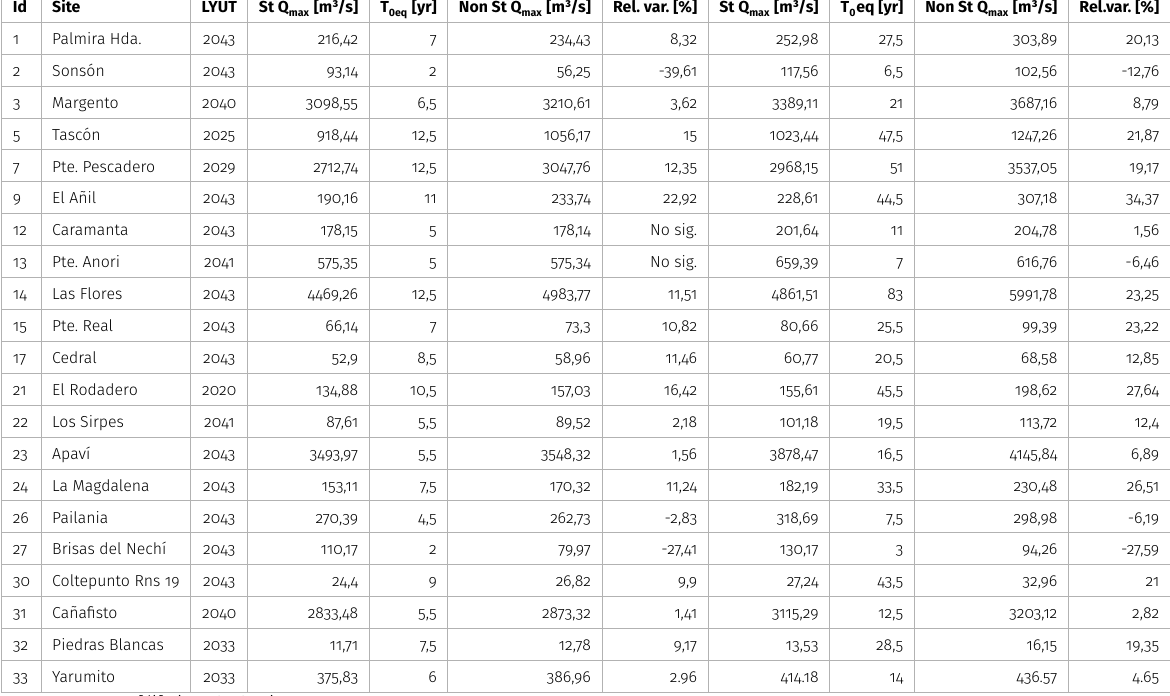
Figure 4. Effect of the non-stationarity approach in the design flood for 5-yr and 10-yr return period. Qs and Qns are the stationary and non-stationary flow estimations. Table IV. Maximum discharges and increase (+) or decrease (-) percentages of stationary maximum discharge for quantile